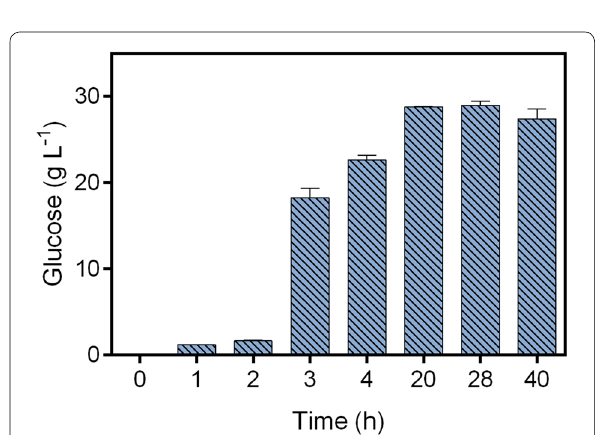
Fig. 2 Glucose concentration in the enzymatic hydrolysis of 10% load S. platensis biomass with α‑amylase (37.8 KNU), glucoamylase (30 AGU) and cellulase (12 FPU per gram of